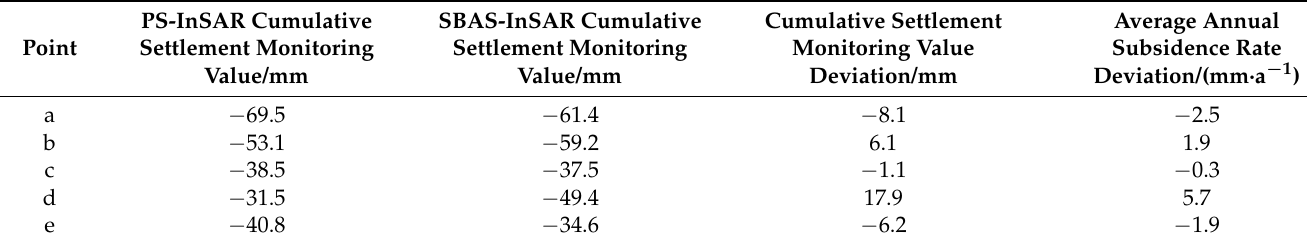
Table 3. Detailed cumulative time series analysis and deviations results.